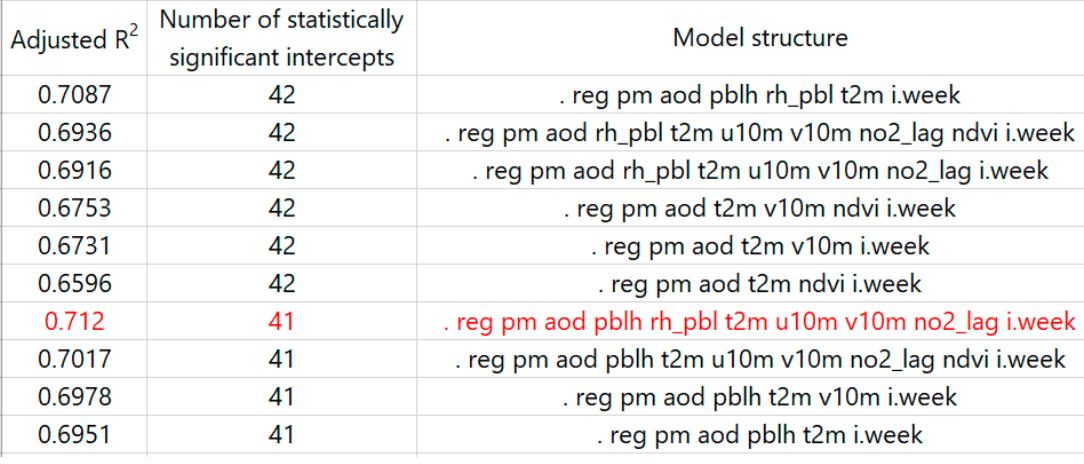
Figure A2. Screenshot of determining the best model structure for the TFER model with weekly intercepts.